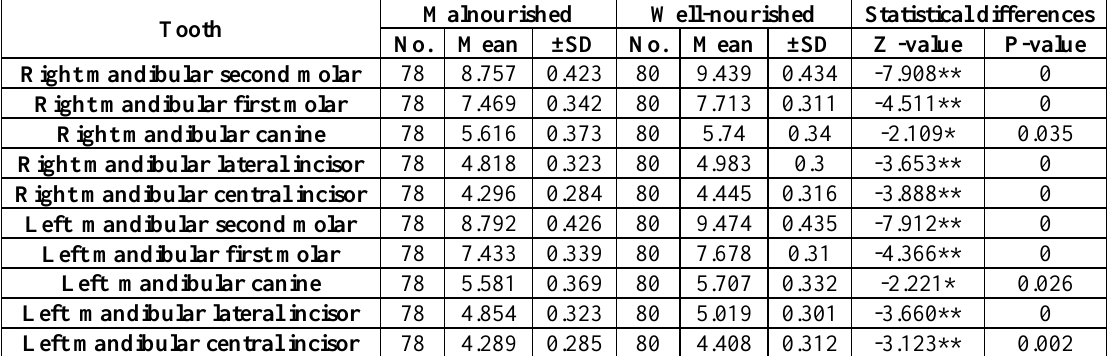
Table 3: Measurement of bucco-palatal diameters (mm) of maxillary teeth in malnourished and well-nourished group among children aged 5 years by gender Malnourished Well-nourished Statistical differences Tooth No. Mean Right maxillary second